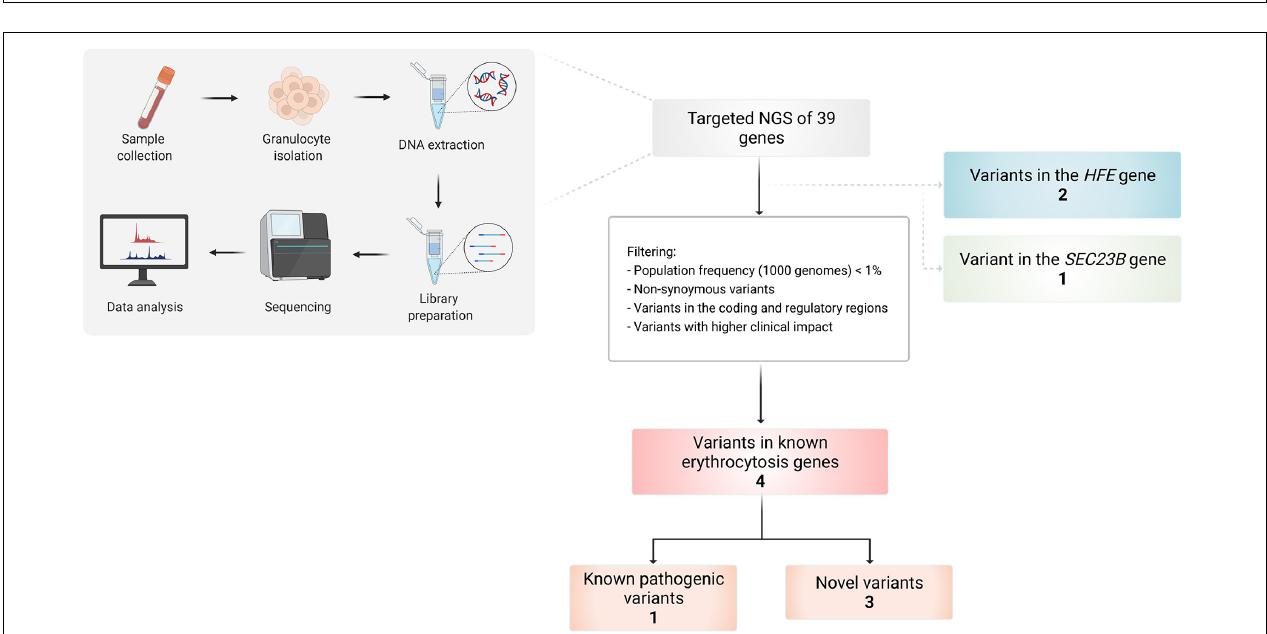
FIGURE 3 | Workflow of the study and overview of the identified variants in selected patients using targeted NGS of 39 genes.